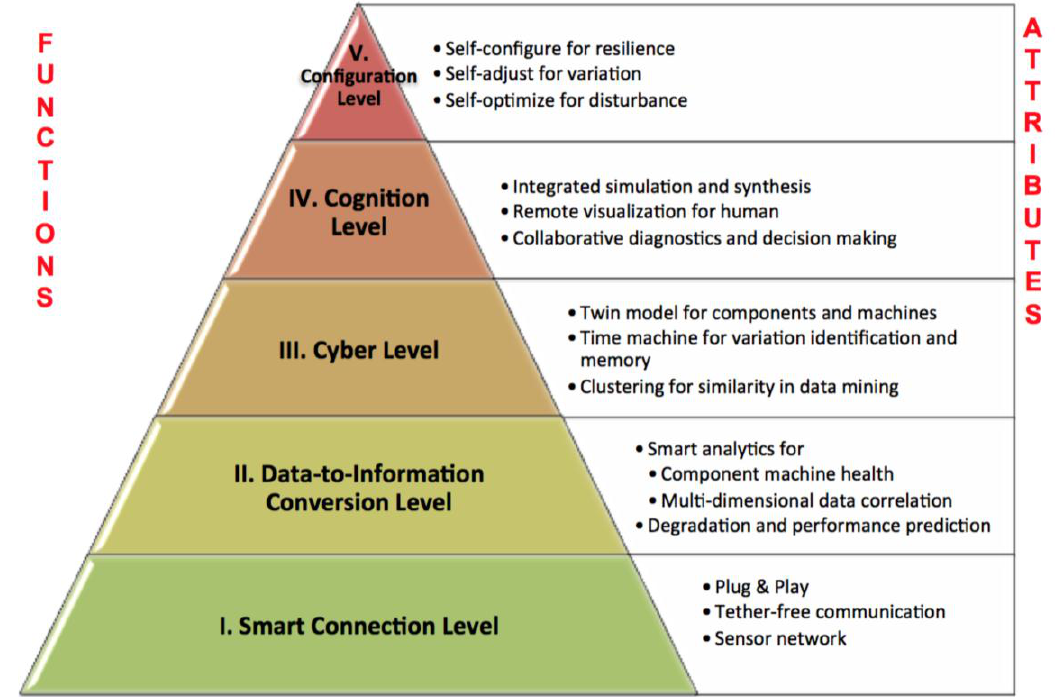
Figure 2. Cyber-Physical System Value